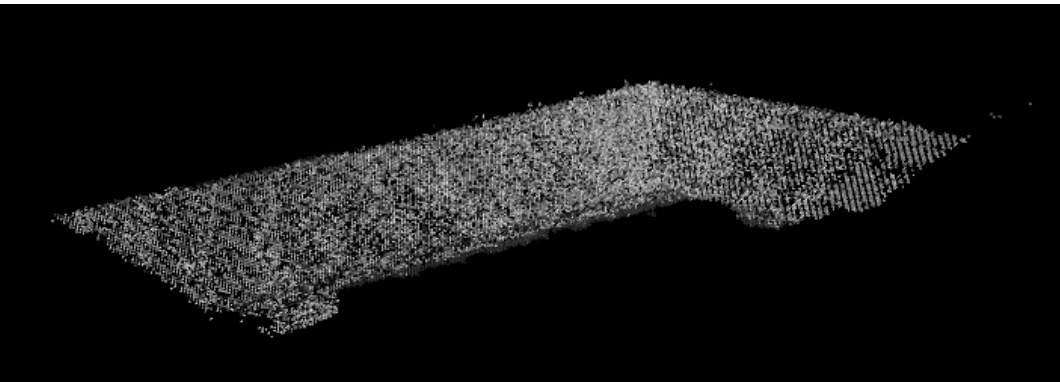
Figure 10. Reconstruction performed through the manual